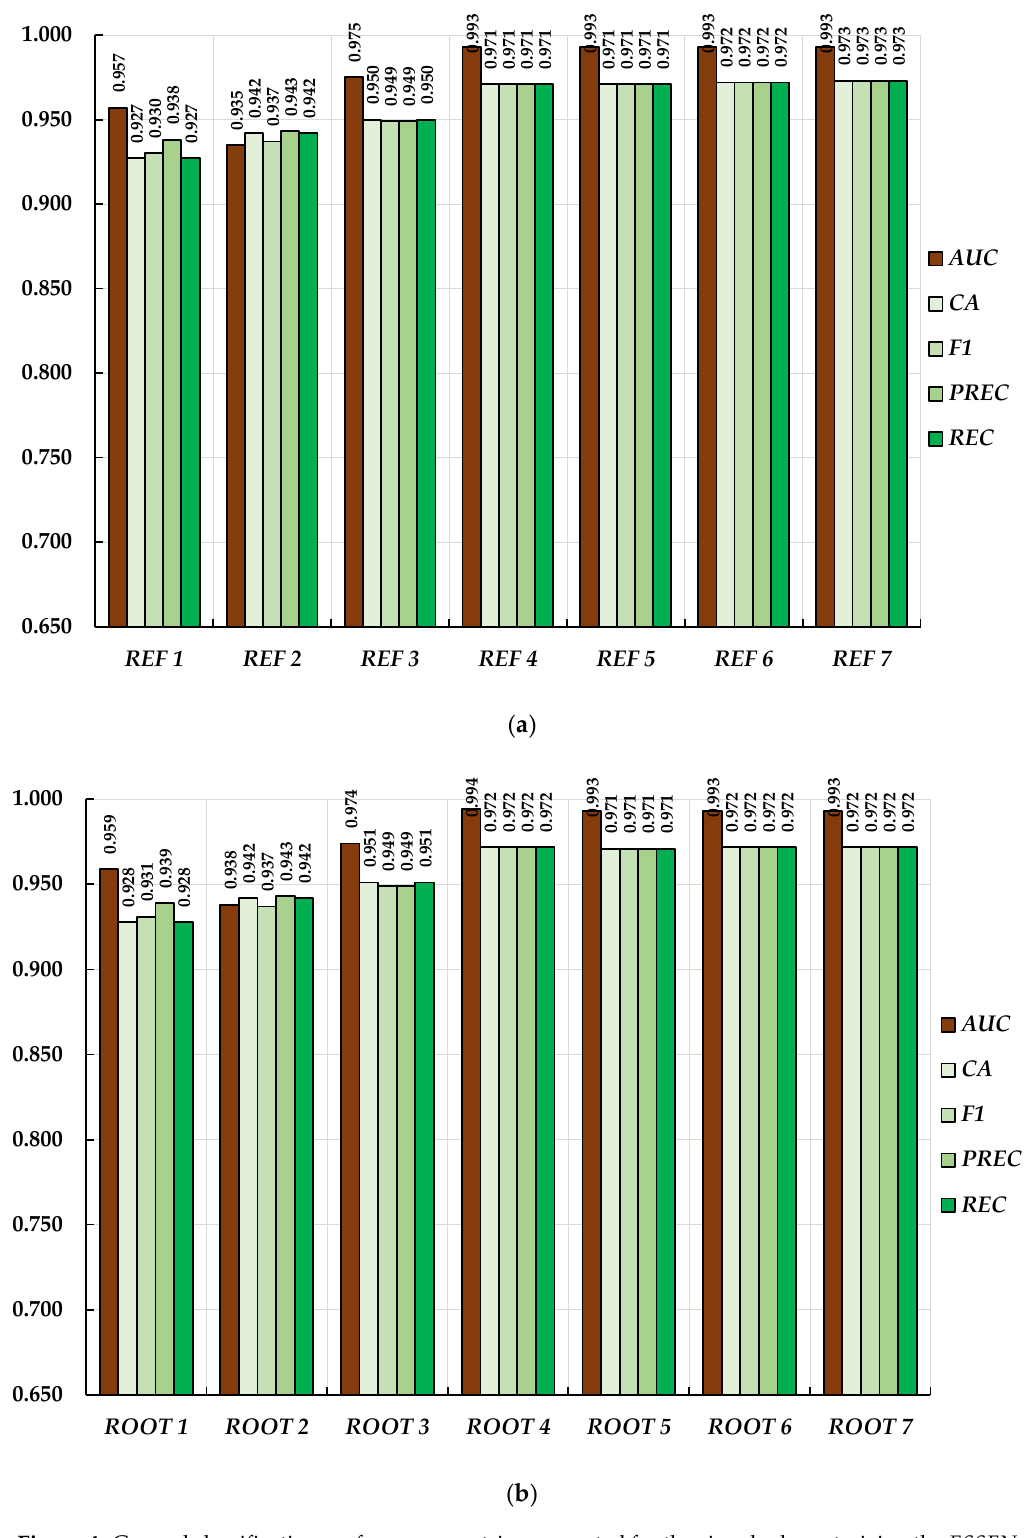
Figure 4. General classification performance metrics computed for the signals characterizing the ESSEN resolution: ( a ) classification performance metrics for the REF signals, ( b ) classification performance metrics for the ROOT signals. Legend: REF1—REF7 and ROOT1—ROOT7 have the meanings given in Table 3, AUC —area under curve, CA —classification accuracy, F1 —harmonic mean of PREC and REC , PREC —precision, REC —recall.